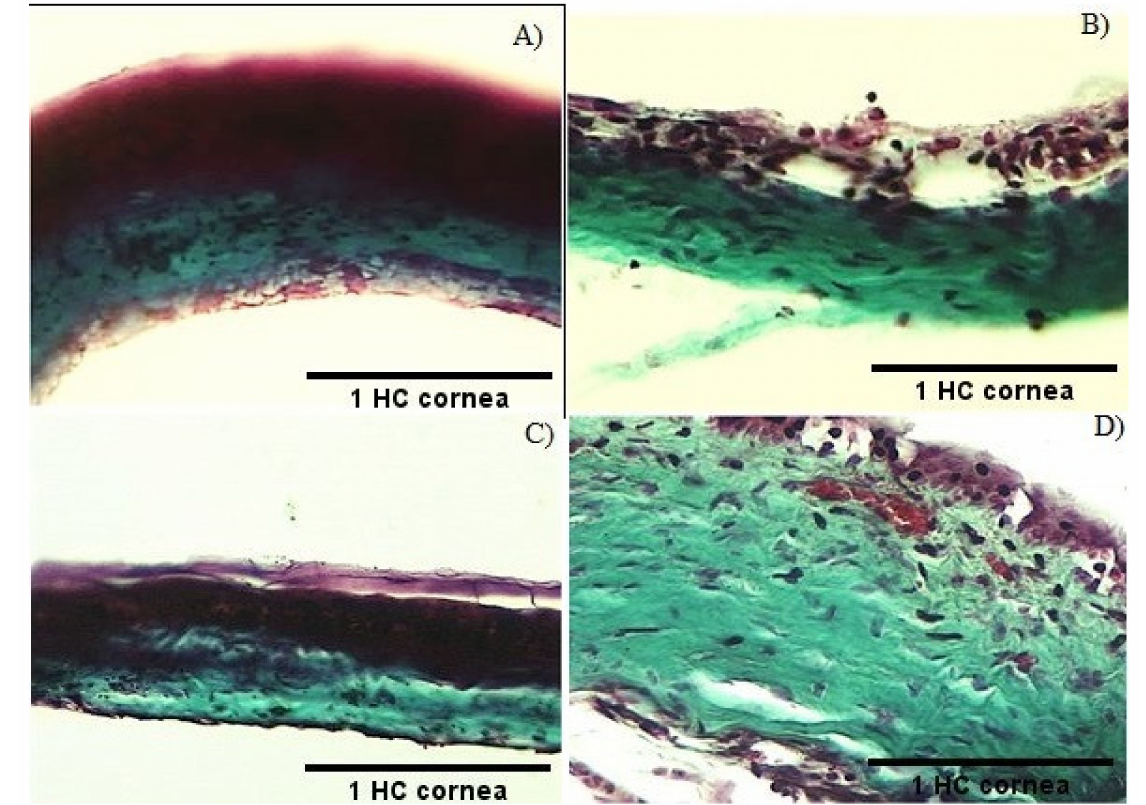
Figure 7. Histological section of cornea stained by Gomori’s trichrome technique from groups that presented injuries. Stained in black is the cell nuclei, in blue the collagen, and in red the muscle endothelium. In ( A ) panel in a healthy cornea, HC group, the intermediate layer called stroma was of the same thickness as the corneal epithelium (20 × ). The ( B ) panel shows the portion of the cornea belonging to NegCtrl, where the corneal epithelium decreased in thickness with respect to the stroma and presents an apparent decrease in the density of the cell population, with the opening of spaces between cells and detachment of a few (20 × ). In ( C ) panel in the Dex group, there is detachment of the epithelial layer and apparent opening of spaces in the stroma stained in blue (20 × ). The TxD group on ( D ) panel presented cell detachment in both the epithelium and the endothelium, and an apparent increase in the density of the cells is observed, evidenced by higher red staining spots on the epithelial surface (40 × ). Scale bar = 131.0343 pixels is the thickness of the HC cornea and is compared with the other